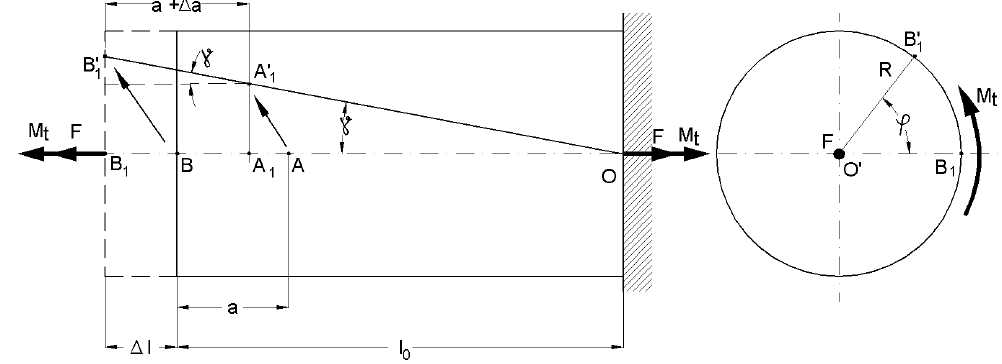
Figure 5. The drawing of the displacement of the fixing points on the sample under tensile–torsion